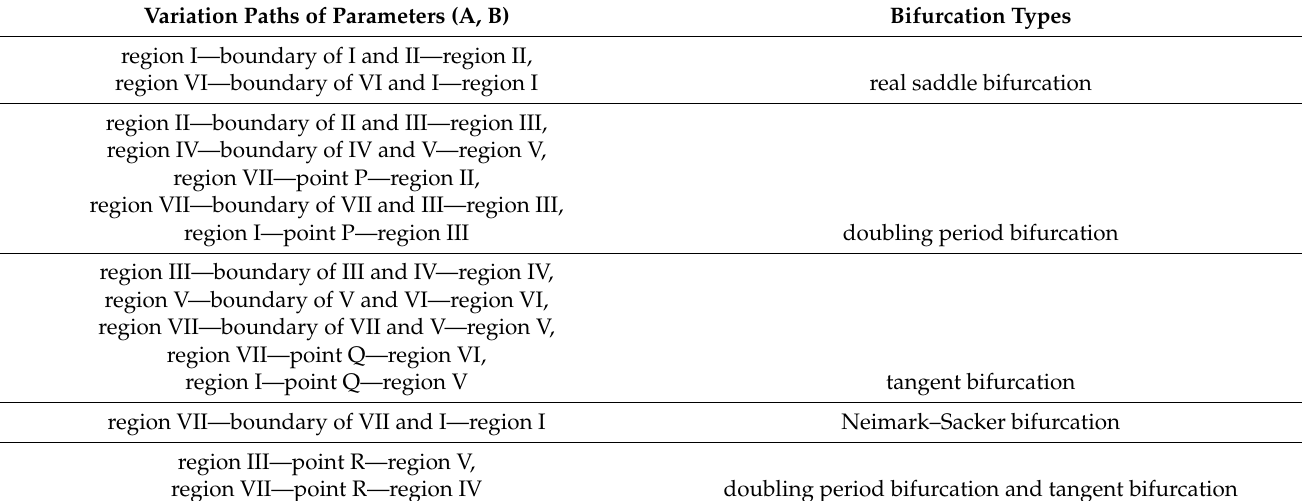
Table 3. Some bifurcation paths of periodic orbits as parameters (A, B)